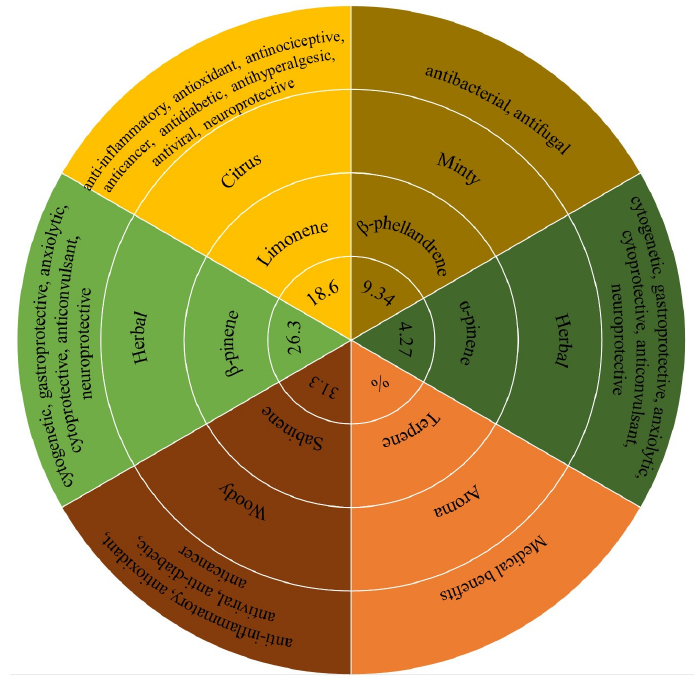
Figure 1. Terpene profile chart of kaffir lime essential